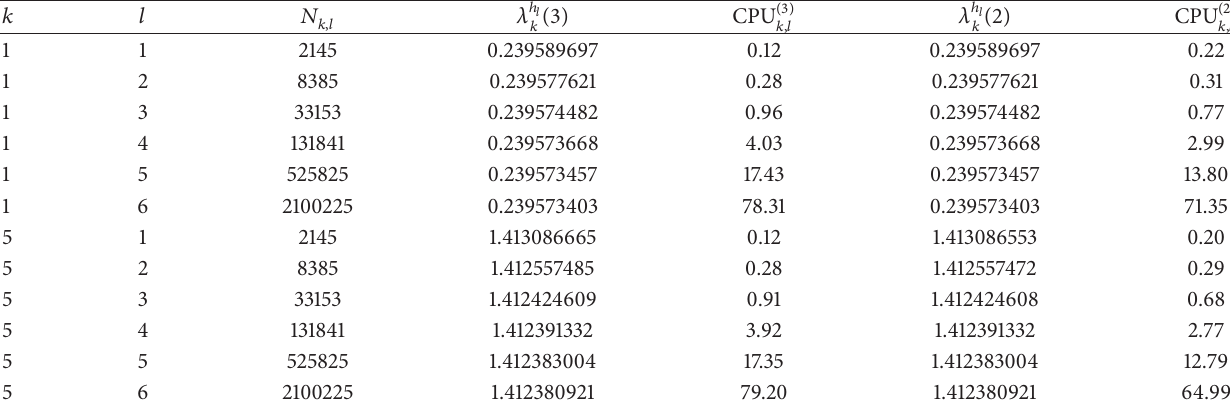
Table 6: The results of Example 4 on Ω = {(𝑥 1 ,𝑥 2 ) : |𝑥 1 | + |𝑥 2 | < 1}\{(𝑥 1 , 𝑥 2 ) : 0 ≤ 𝑥 1 ≤ 1, 𝑥 2 = 0}